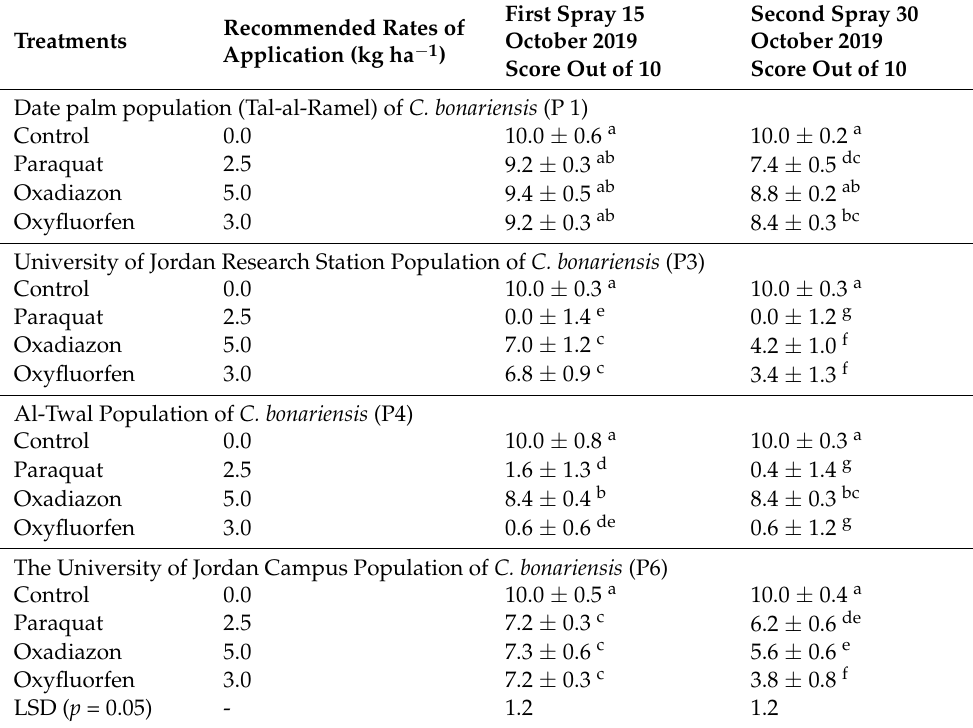
Table 4. The effect of field rate application of three herbicides sprayed at two dates at the full vegetative growth stage of four populations of C. bonariensis grown in a pot experiment.